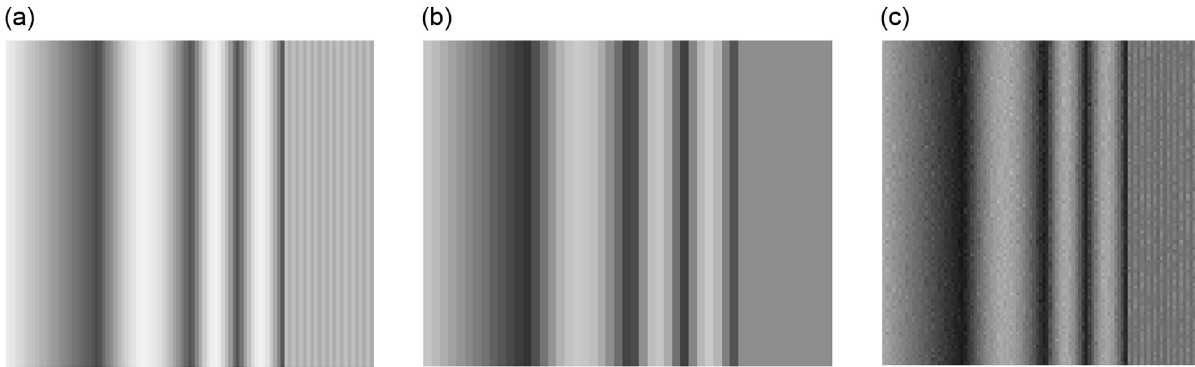
Fig 3. (a) depicts the log transformed detector signal (i.e., projection integral) from the 1x1 mm simulated detector element at 120 kV. (b) depicts the log transformed detector signal (i.e., projection integral) from the 1x2 mm simulated detector element at 120 kV. (c) depicts the SPE derived 60 keV projection line integral reconstructed using data only from a 1x2 mm detector. Pay attention to the right side of the images, the high frequency bone modulation pattern is only visible on the 1 mm and 1 mm SPE derived images. Images are unitless arguments to an exponential function (i.e., projection line integrals) and are displayed at a window setting of [0.4